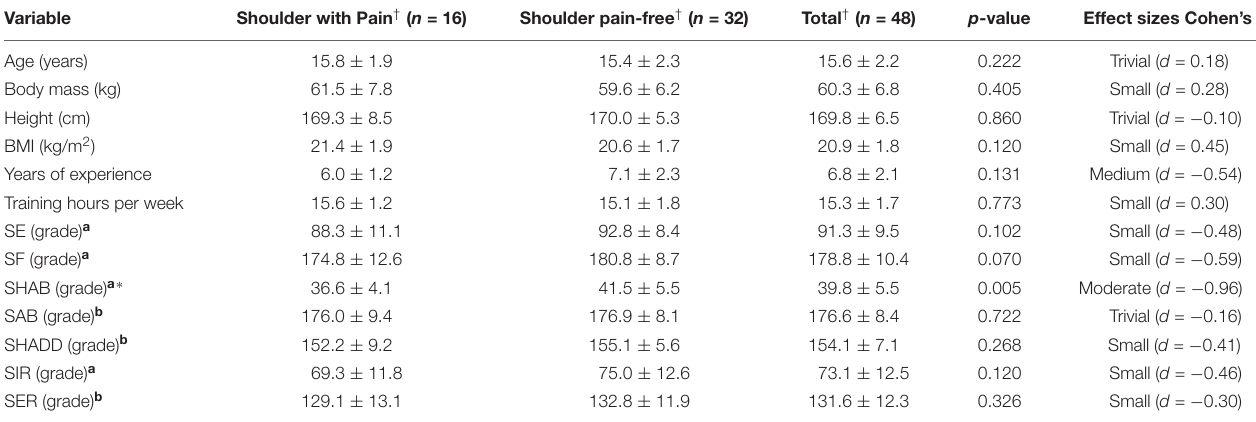
TABLE 2 | Results of variables for the 24 young swimmers (48 shoulders) who developed shoulder pain and those who did not (control). Variable